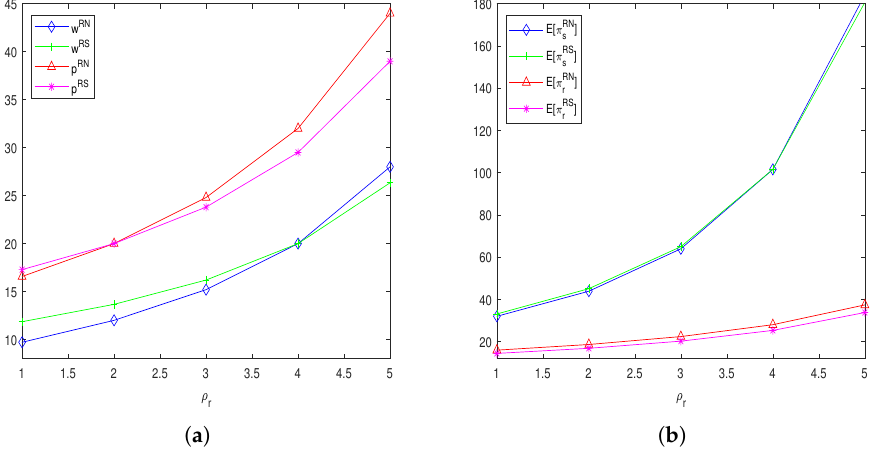
Figure 3. Impact of the freshness-keeping efficiency ρ r on the prices and profits in the RN and RS cases. ( a ) Effect of ρ r on the wholesale and retail prices; ( b ) effect of ρ r on the equilibrium profits.